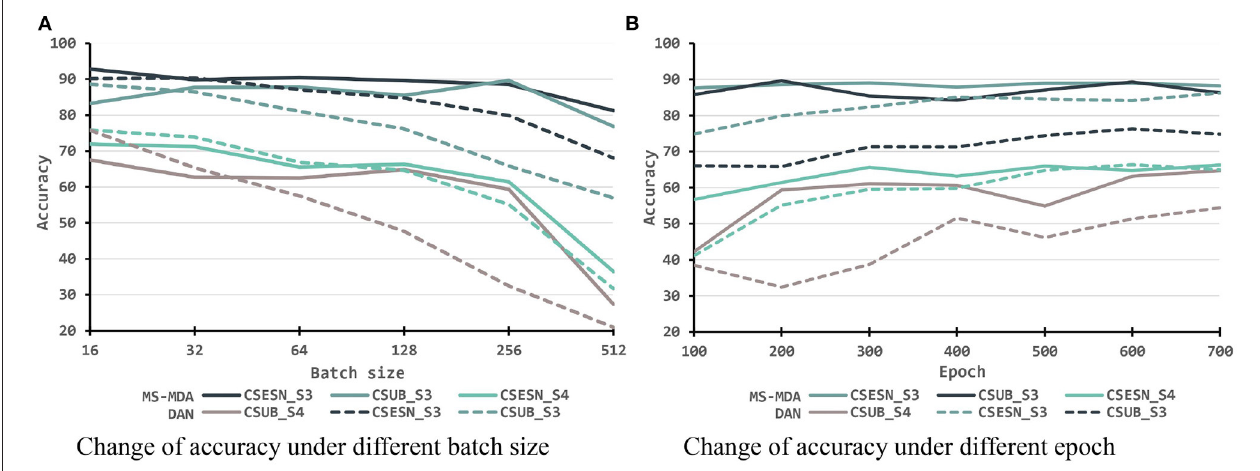
FIGURE 7 | Evaluation of MS-MDA and DAN with different settings of batch size and epochs. The color lines from top to bottom stand for eight transfer scenarios: cross-session for SEED of MS-MDA, cross-subject for SEED of MS-MDA, cross-session for SEED-IV of MS-MDA, cross-subject for SEED-IV of MS-MDA; cross-session for SEED of DAN, cross-subject for SEED of DAN, cross-session for SEED-IV of DAN, cross-subject for SEED-IV of DAN. (A) Change of accuracy under different batch size. (B) Change of accuracy under different epoch.